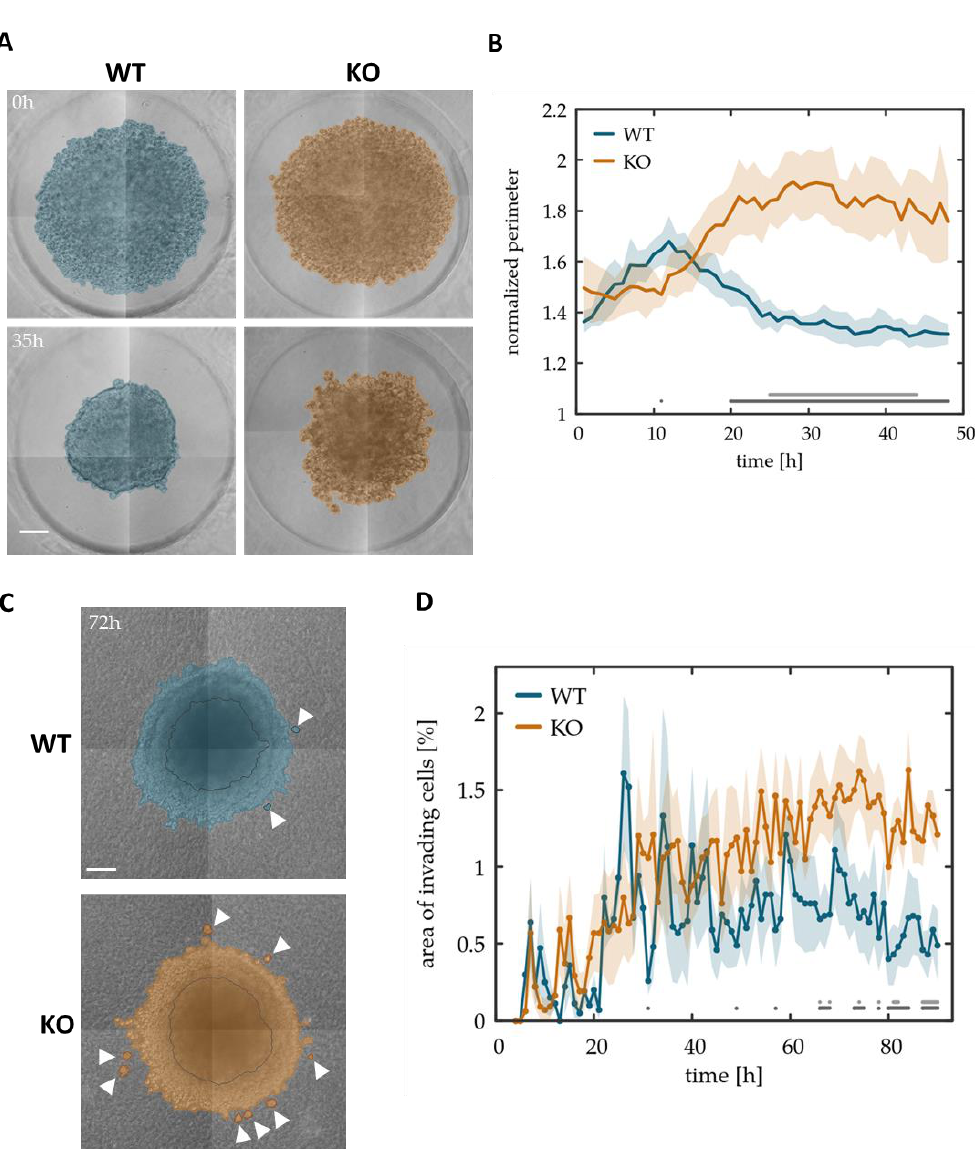
Figure 4. Tks4-KO cells form looser aggregates and invade in small clusters. ( A ) Representative spheroids of 3000 WT (WT) and Tks4-KO (KO) cells in non-adhesive agarose wells. Experiment was conducted in triplicates, scale bar represents 100 µm. Color indicates the cell-covered area, identified by our image processing tools. ( B ) Spheroid shape is characterized by the normalized perimeter, the ratio of the actual perimeter and that of a circle with the same area. Solid lines indicate an average of 9 spheroids, the shaded areas represent the SEM. Statistically significant differences between wild type and Tks4-KO cells are indicated at the bottom of the chart. Dark and light gray dots represent a p -value lower than 0.05 and 0.01, respectively, obtained by unpaired Student’s t-tests performed at each time point. ( C ) Representative images of spheroids embedded in type-I collagen matrix. Initial spheroid size is indicated with dark outline. Cells leaving the spheroids and invading into the matrix either as solitary cells or in small groups are marked by white arrowheads. ( D ) Time dependence of the area occupied by invading cell clusters, not connected to the central aggregate. Area values were normalized by the total cell-covered area in the micrograph. Solid lines indicate an average of n = 3 and n = 6 microscopic fields of wild type and Tks4-KO, respectively. The shaded areas represent the SEM. Dark and light gray dots indicate p -values lower than 0.05 and 0.01, respectively, established by unpaired Student’s t-tests performed at each time point.